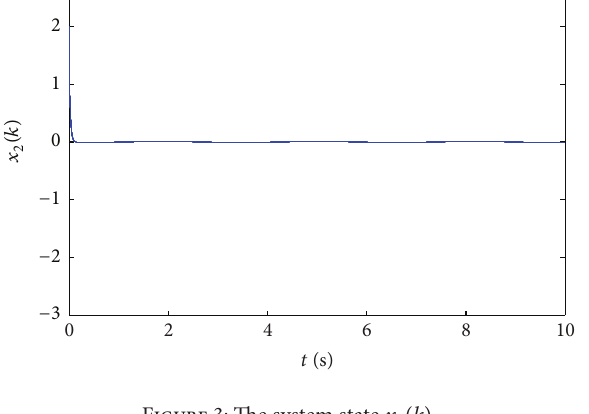
Figure 3: The system state 𝑥 2 (𝑘) .